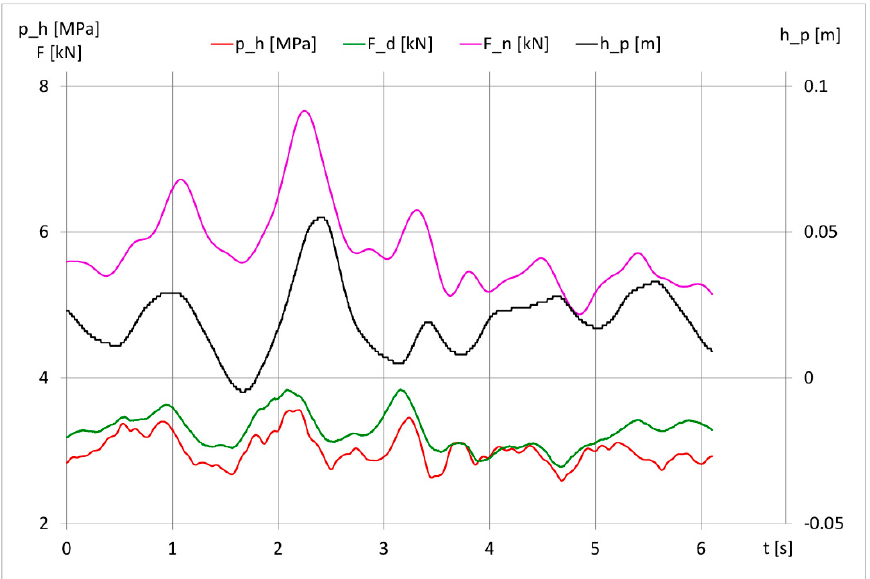
Figure 4. Changes in time of hydraulic pressure p h , drawbar pull F d , driving force F n , and position of the implement linkage system h p ; soil profile—medium clay, third gear, operating depth 0.09 m.